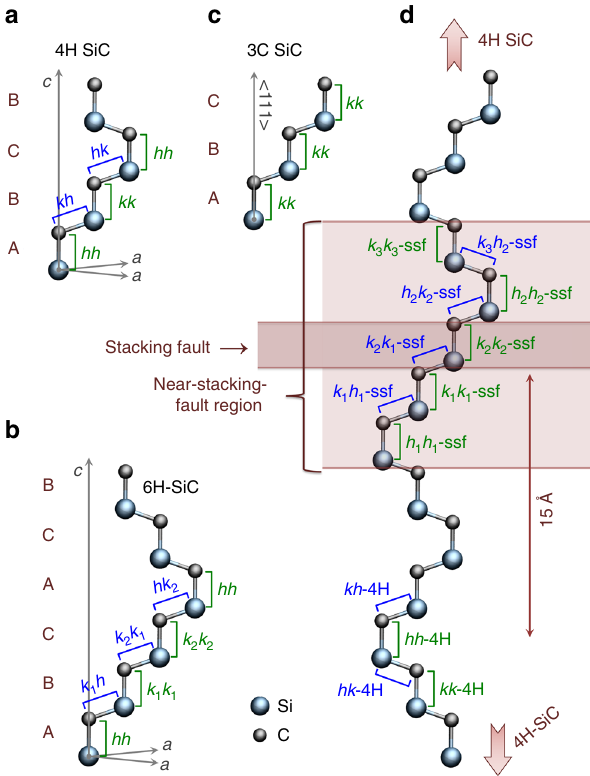
Fig. 2 Common SiC polytypes and structure of a stacking fault in 4H-SiC. a – c show the primitive cells, the stacking sequences, and the possible divacancy nonequivalent con fi gurations in 4H, 6H, and 3C-SiC, respectively. Here, h and k stand for hexagonal-like and cubic-like environments of Si or C sites, respectively, and the double letters for the vacancy sites of the V Si – V C divacancy pair defect con fi gurations. d A single stacking fault in a cubic-like stacking order in 4H-SiC. The close vicinity of the stacking fault resembles the 6H stacking and thus it gives rise to 6H- like additional divacancy con fi gurations in 4H-SiC. The k 2 k 2 -ssf con fi guration is assigned to PL6 room-temperature